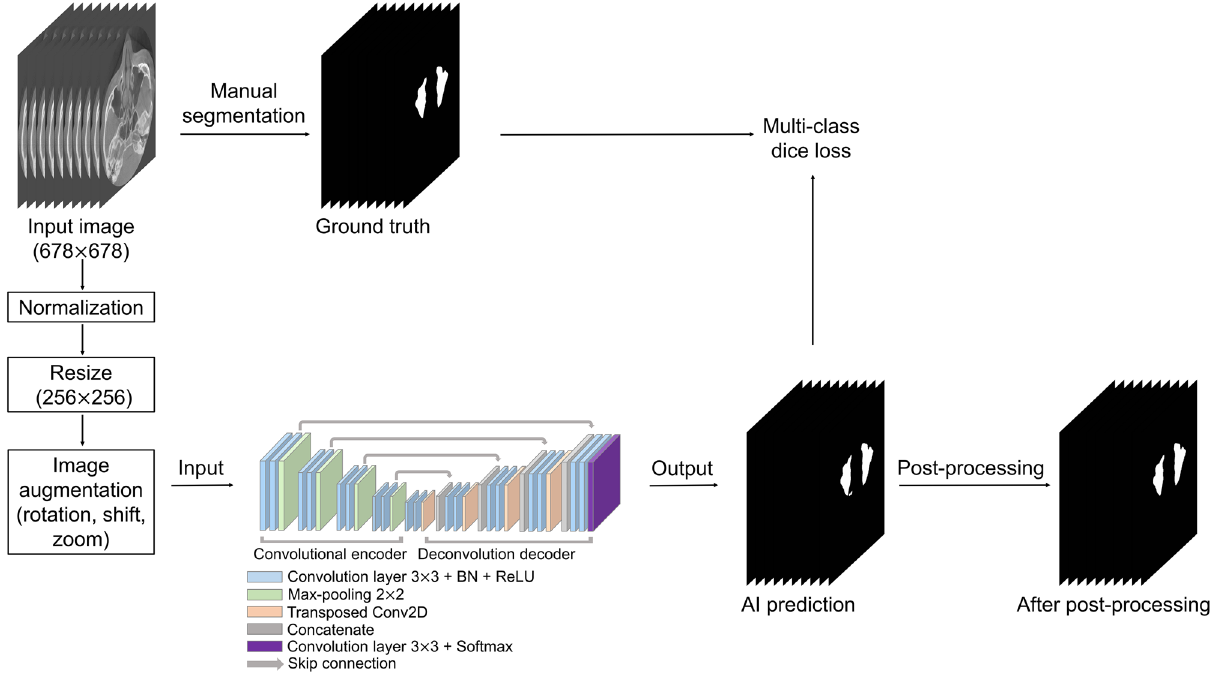
Figure 2. Overall process of our study.